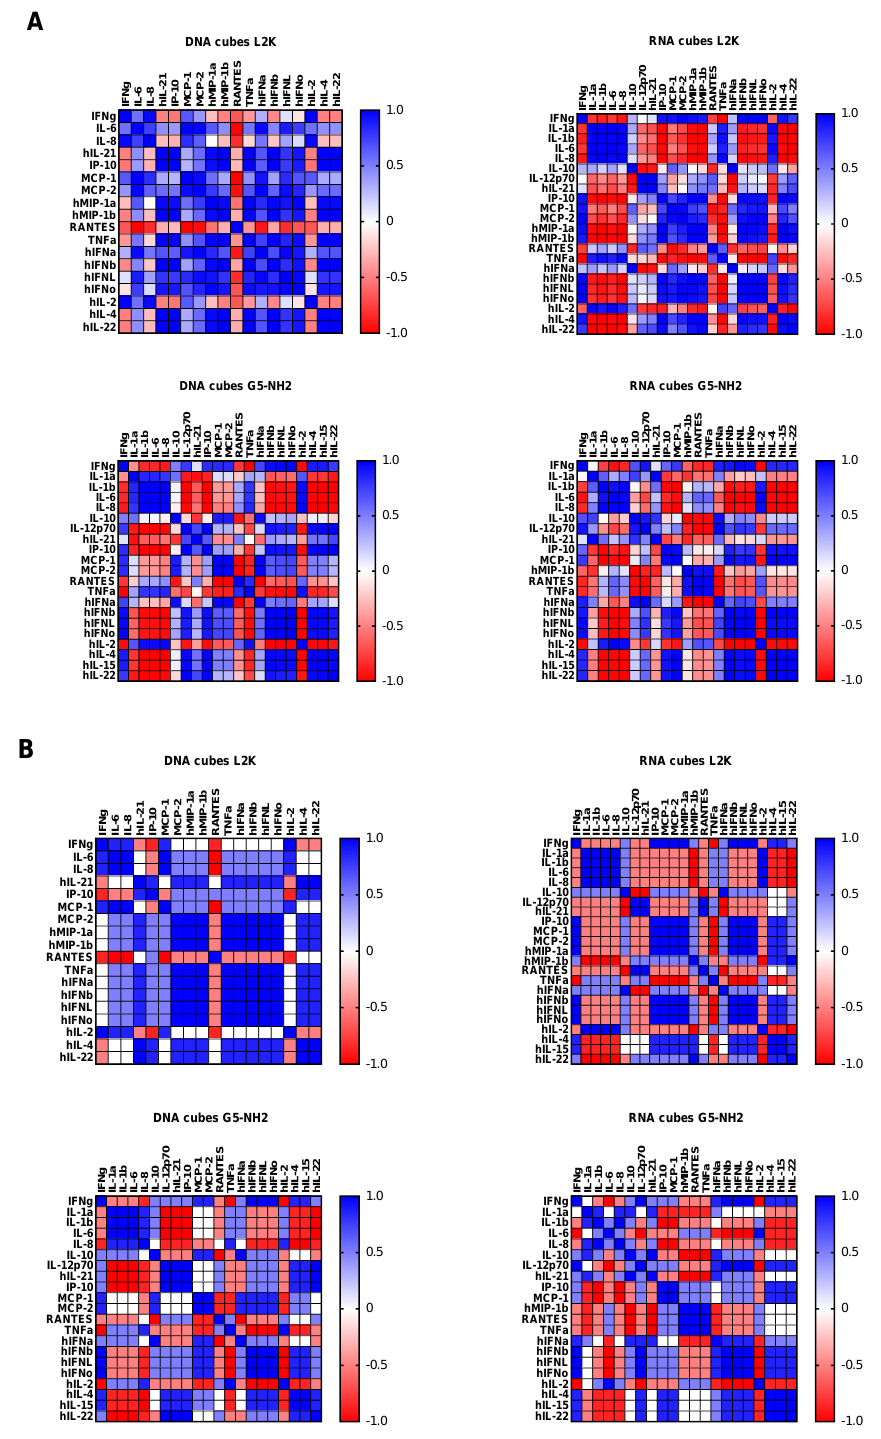
Figure 6. Correlation analysis of cytokine response. The data from the multiplex cytokine analysis including those presented in Figure 5 were analyzed using the GraphPad Prism software to determine a correlation or lack thereof between individual cytokines. ( A ) The Pearson correlation matrix assumes a Gaussian distribution (parametric analysis). In this analysis, values between ± 0.5 and ± 1 refer to a high degree of correlation, whereas values close to ± 1 mean perfect correlation; negative values (in red) refer to the negative correlation, whereas positive values (in blue) mean positive correlation. ( B ) The Spearman correlation matrix assumes no Gaussian distribution (non-parametric analysis). In this analysis, values of ± 1 mean perfect correlation; the closer the value is to zero, the weaker the association is; negative values (in red) and positive values (in blue) refer to the negative and positive correlation, respectively.